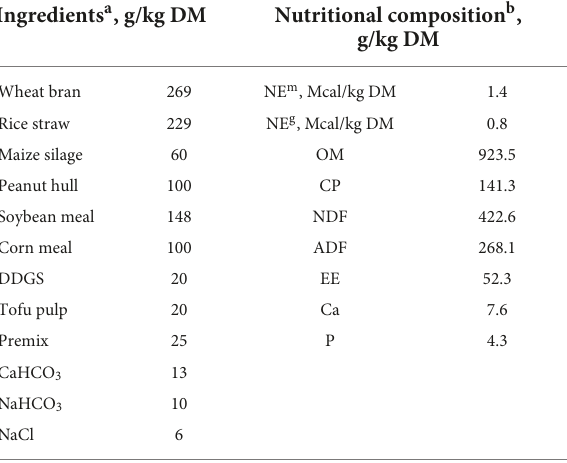
TABLE 1 Components and nutritional composition of the basal TMR